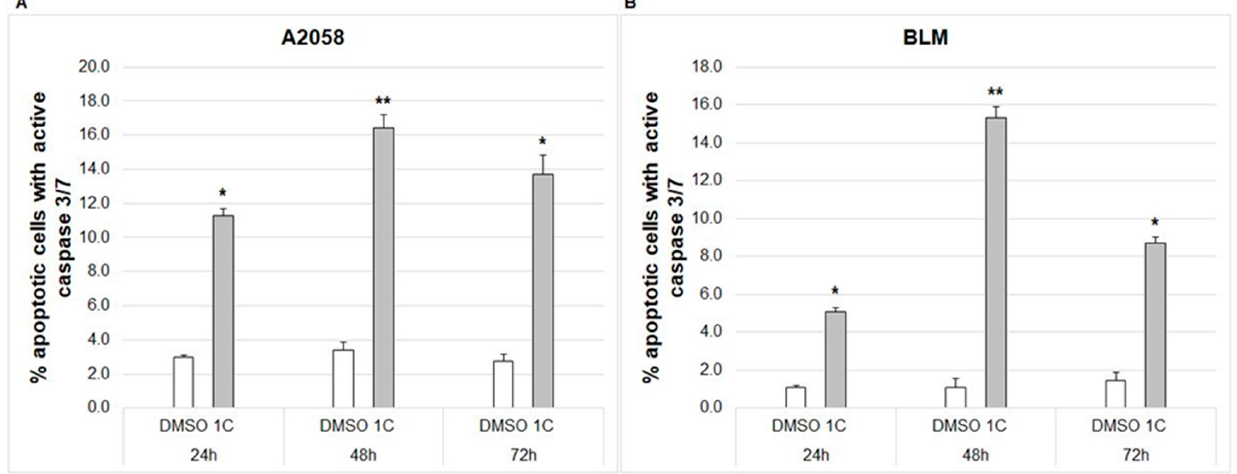
Figure 10. Flow cytometric analysis of caspase-3/7 activity in A2058 ( A ) and BLM ( B ) melanoma cells after 24, 48 and 72 h of treatment with chalcone 1C at concentrations of 10 μ mol/L (A2058) and 20 μ mol/L (BLM). The data show the mean ± SD values of three independent experiments. Statistical significance: * p < 0.05, ** p < 0.01 vs. DMSO (vehicle).